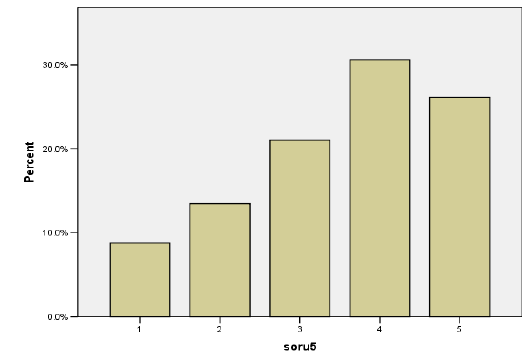
Figure 5: Is it beneficial to include TCC and TAS to higher education curricula?